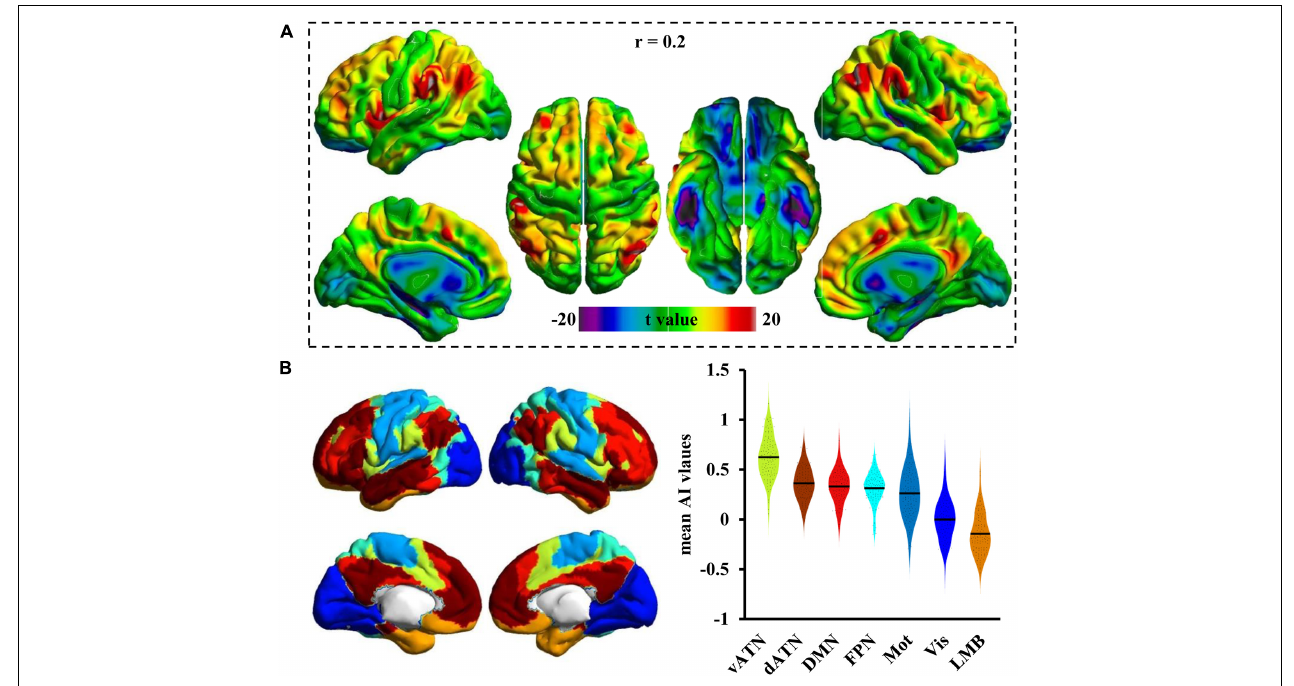
FIGURE 2 | The distribution pattern of the Asso in the cortex. (A) The whole brain Asso map was calculated at a predefined threshold of 0.2, and one-sample t -test was used to identify the distribution pattern in cortex. (B) The human cortex was divided into seven subnetworks, and the mean Asso value was calculated for each network. The Asso distributions from the largest to the smallest were found in the ventral and dorsal attention network (vANT, dANT), default mode network (DMN), frontoparietal network (FPN), somatomotor network (Mot), visual network (Vis), and limbic network (LMB).